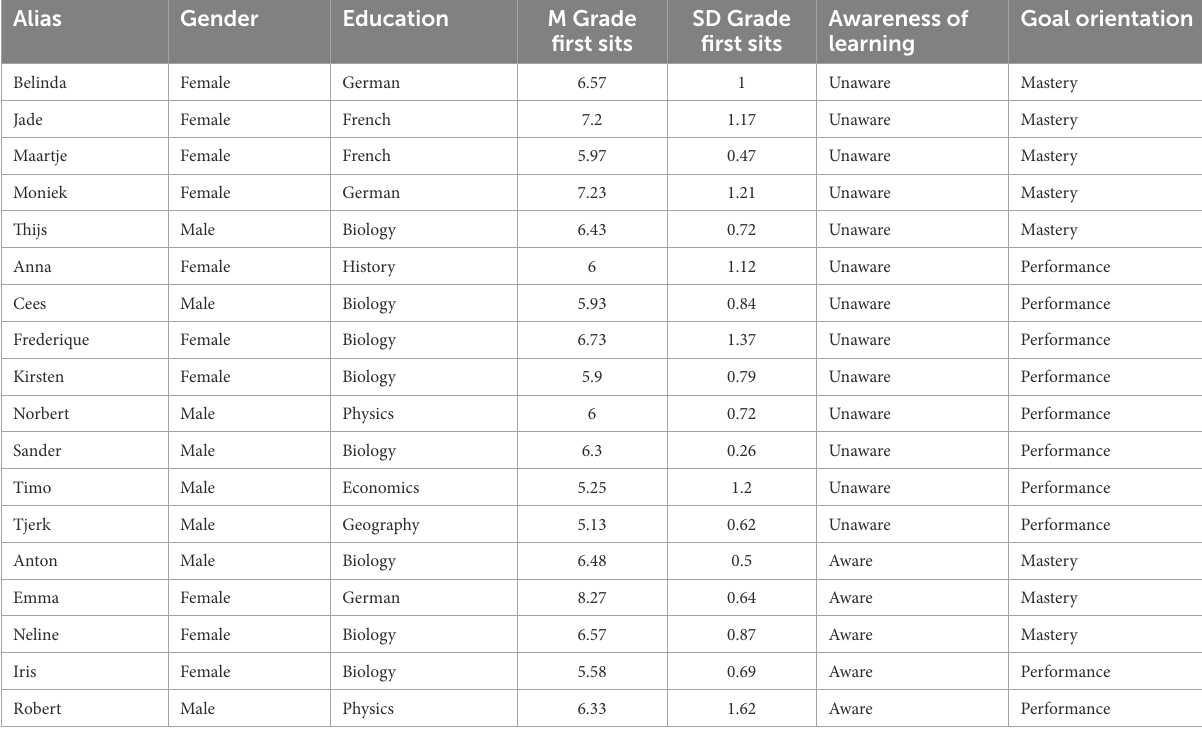
TABLE 1 Student characteristics: grades, awareness of learning and goal orientation.